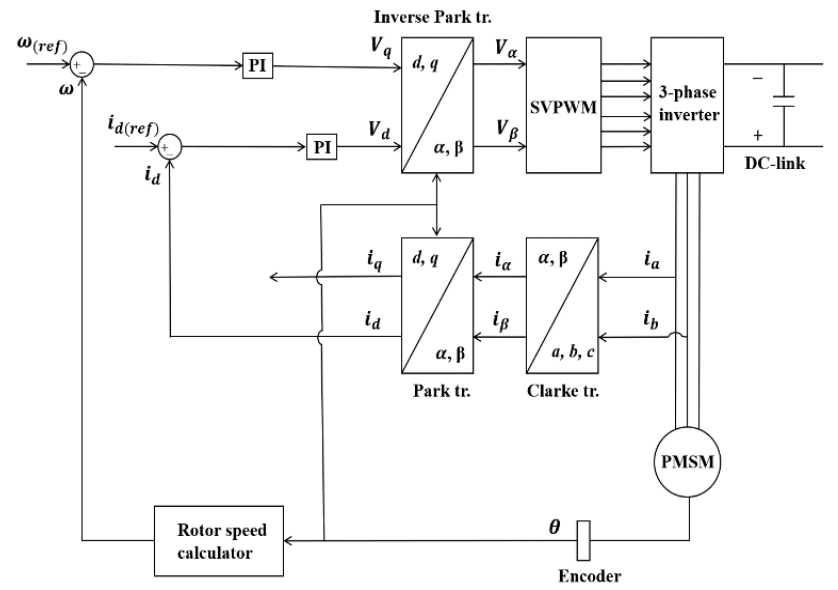
Figure 2. Simplified control scheme.